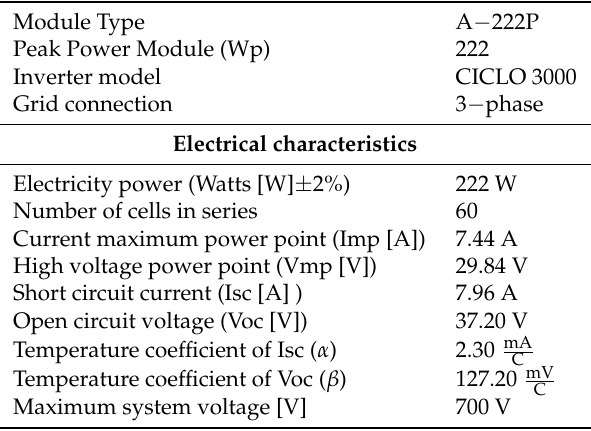
Table 2. Summary for the PV module.